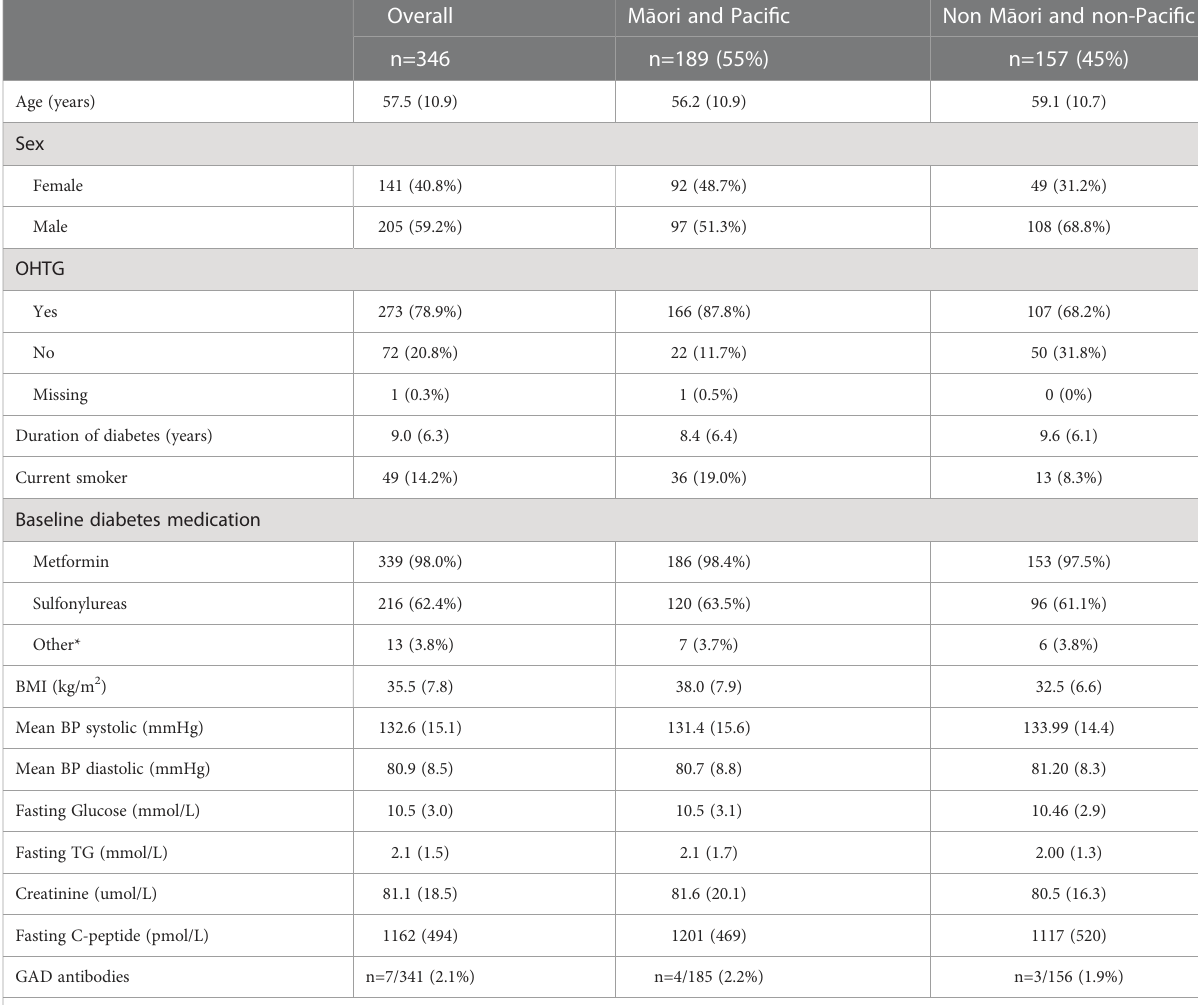
TABLE 1 Baseline demographics and clinical characteristics.